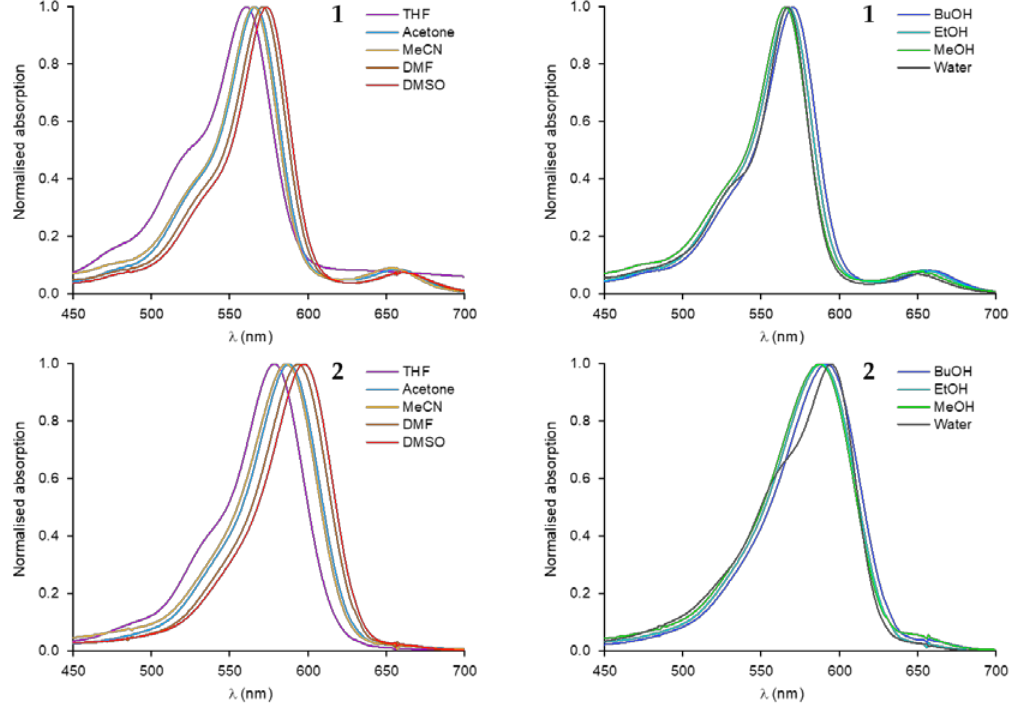
Figure 2. Normalized absorption spectra of the merocyanine dyes (10 μM): meroBA-COOH ( 1 ) and meroSO-COOH ( 2 ) in a series of aprotic ( left ) and protic solvents ( right ).